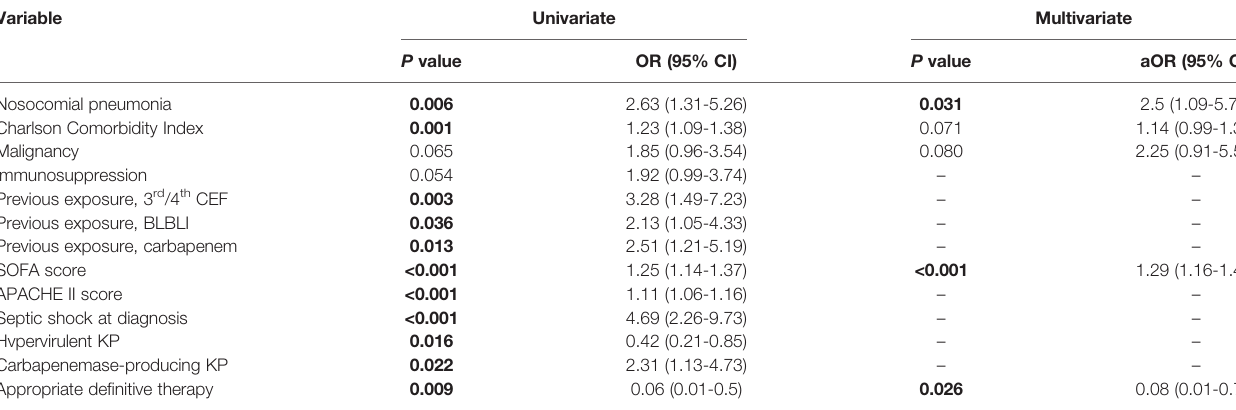
TABLE 5 | Logistic regressions for variables associated with 28-day mortality.